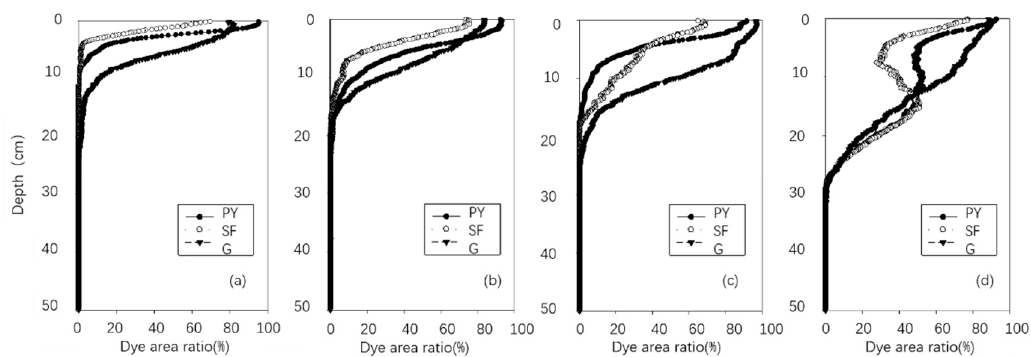
Figure 4. Average DC curve under different precipitation amounts (( a ) is G5, ( b ) is G15, ( c ) is G35, ( d ) is G55). PY corresponds to Pinus Yunnanensis forestland, SF corresponds to secondary forestland, and G corresponds to natural grassland. Among them, G5, G15, G35, and G55 correspond to 5 mm, 15 mm, 35 mm, and 55 mm ponded water infiltration simulation, which simulate the change of ponded water in light rain, medium rain, heavy rain, and storm, respectively.